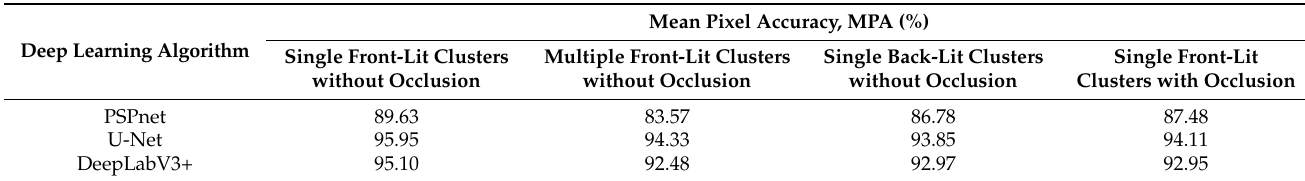
Table 3. The MPA comparison of deep learning segmentation